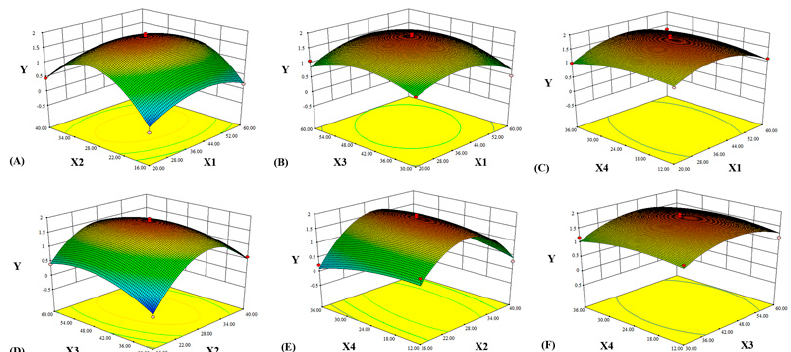
Figure 5. Response surface showing the interaction effects of different parameters ( A : X 1 and X 2 ; B : X 1 and X 3 ; C : X 1 and X 4 ; D : X 2 and X 3 ; E : X 2 and X 4 ; F : X 3 and X 4 ) on the response Y ( X 1 : ethanol concentration, %; X 2 : liquid-solid ratio, mL/g; X 3 : extraction time, min; X 4 : soaking time, h).